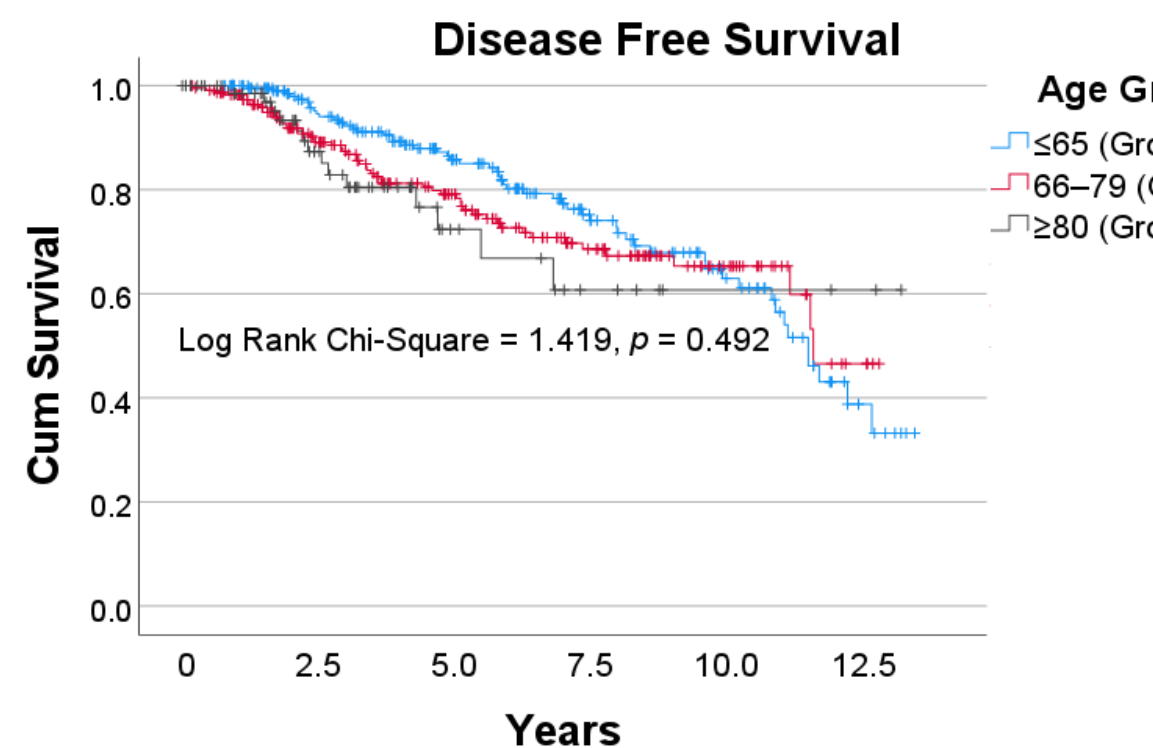
Figure 3. Disease Free survival for patients that underwent curative treatment across the three age groups. Vertical tick marks along each survival curve indicate censorship—i.e., the last follow up where there was no evidence of disease